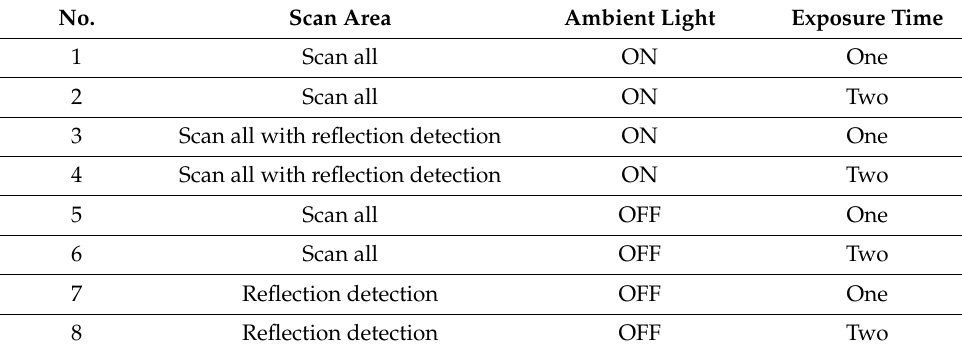
Table 2. Eight measurement strategies proposed in this work. No. Scan Area Ambient Light Exposure Time Scan all ON ON Scan all with reflection detection ON Scan all with reflection detection